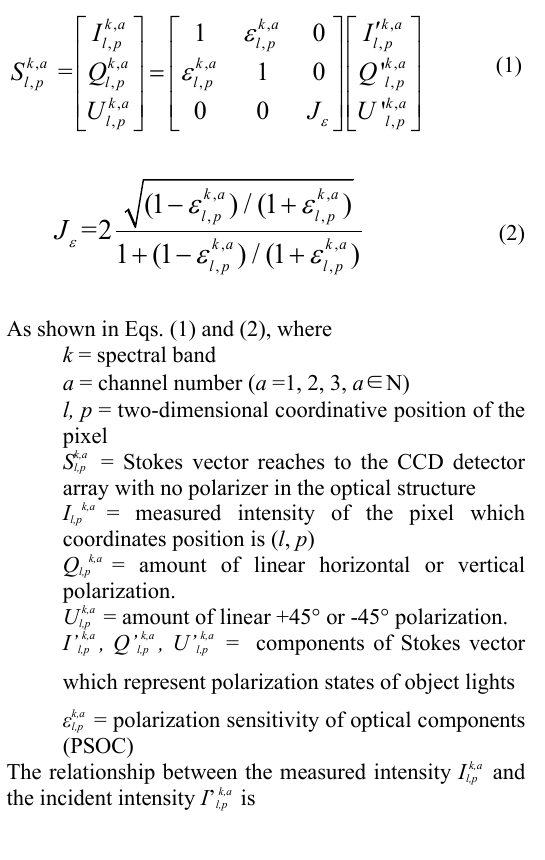
rotating the wheel bearing, polarization information of the target is obtained.